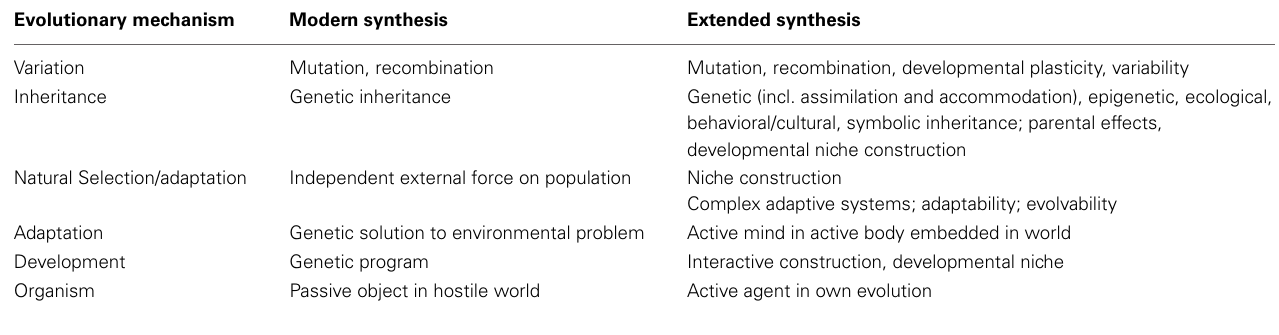
Table 1 | A comparison between the modern and the extended